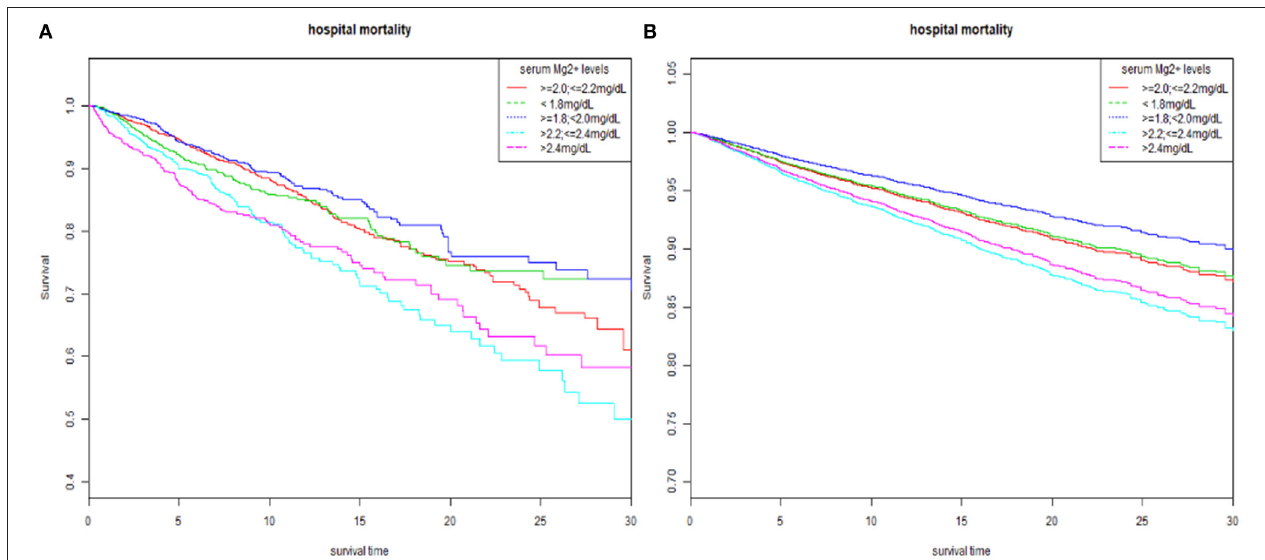
FIGURE 2 | The K-M survival curve of five strata of serum magnesium. (A) Unadjusted K-M survival curve. (B) Adjusted for age, ethnicity, gender, hypertension, CHF, diabetes, PVD, prior MI, atrial fibrillation, valvular disease, cardiogenic shock, cardiac arrest, HC, HR, SBP, DBP, MBP, norepinephrine, dopamine, epinephrine, Mg supplement, WBC, PLT, RBC, Hb, BUN, Cr, glucose, serum potassium, sodium, bicarbonate, and total calcium. K-M, Kaplan-Meier; CHF, congestive heart failure; PVD, peripheral vascular disease; MI, myocardial infarction; HC, hypercholesterolemia; HR, heart rate; SBP, systolic blood pressure; DBP, diastolic blood pressure; MBP, mean blood pressure; WBC, white blood cell; PLT, platelet; RBC, red blood cell; Hb, hemoglobin; BUN, blood urea nitrogen; Cr, creatinine.